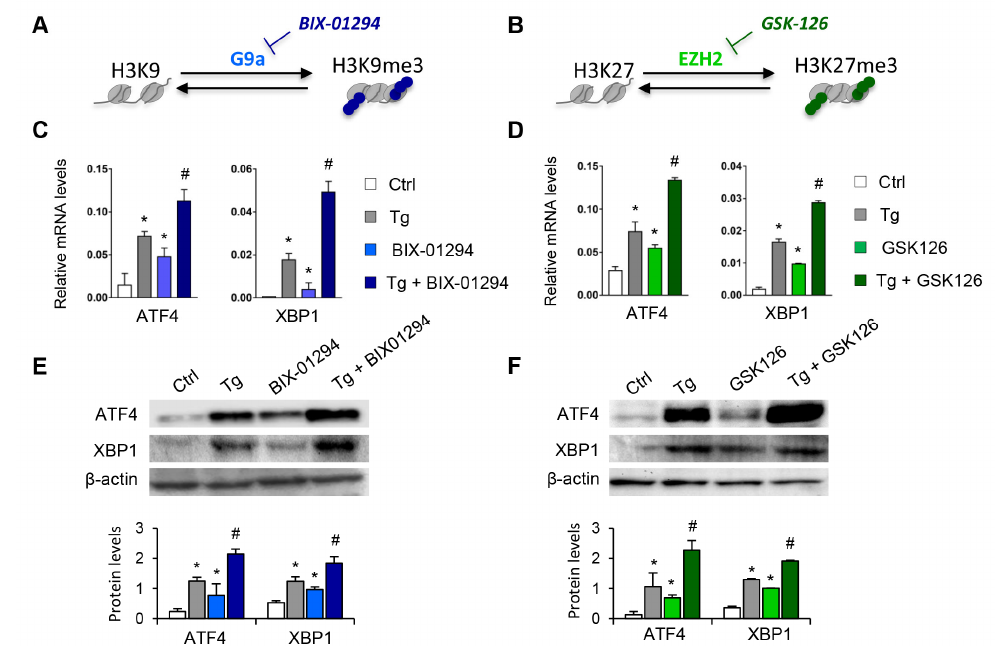
Figure 2. Pharmacological inhibition with BIX-01294 and GSK126 induces the expression of ATF4 and XBP1 in tubule epithelial cells. ( A , B ) Scheme of the effect of the BIX-01294 and GSK126 inhibitors on blocking the G9a and EZH2 histone methyltransferase (HMT) enzymes and on inducing modifications of the methylation of K9 (Lys 9) and K27 (Lys 27) of histone 3 (H3), respectively. Human renal tubular epithelial (HK-2) cells were treated with BIX-01294 (G9a inhibitor, 15 µ M, 24 h) or GSK126 (EZH2 inhibitor, 8 µ M, 24 h) in the absence or presence of thapsigargin (Tg, 4 µ M, 24 h). Cells treated with DMSO were used as a negative control. Gene expression levels of ATF4 and XBP1 were analyzed by quantitative RT-PCR ( C , D ); protein levels were assessed by Western blotting ( E , F ). GAPDH and β -actin were used as controls. Data are presented as the mean ± SEM of at least three independent experiments. * p < 0.05 vs. control (DMSO-treated cells); # p < 0.05 vs. Tg-induced cells.